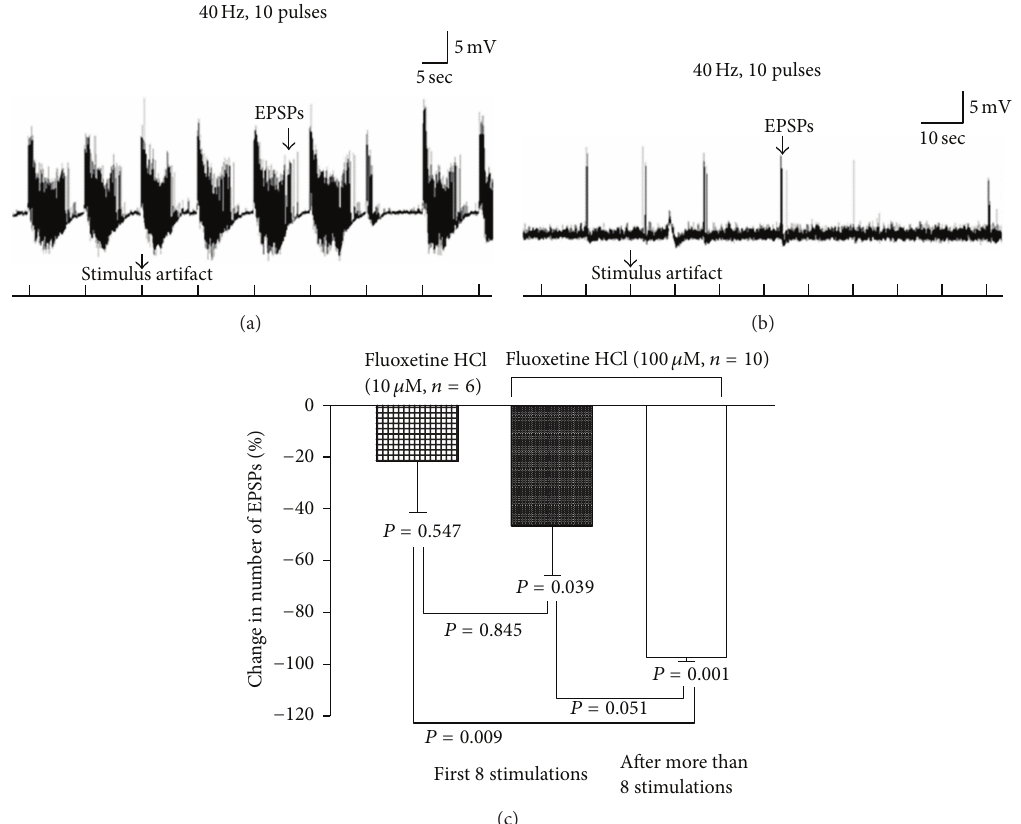
Figure 17: Motor-sensory function and action of a selective serotonin reuptake inhibitor (SSRI). (a) Evoked sensory-motor neural activity (EPSPs) was recorded from body wall muscle fiber 6 or 7 of third-instar larvae in saline. (b) Application of fluoxetine (100 𝜇 M) suppresses the evoked activity of the neural circuitry. (c) Fluoxetine at 10 𝜇 M did not significantly decrease activity but there is a decreasing trend in the mean change in the sensory-motor function. Paired 𝑡 -test was used to compare the frequency of EPSPs inside saline and fluoxetine. One-way ANOVA was used to compare different treatments. Bonferroni 𝑡 -test was employed to obtain significant results. Data represented as mean ± SEM. 𝑃 < 0.05 is